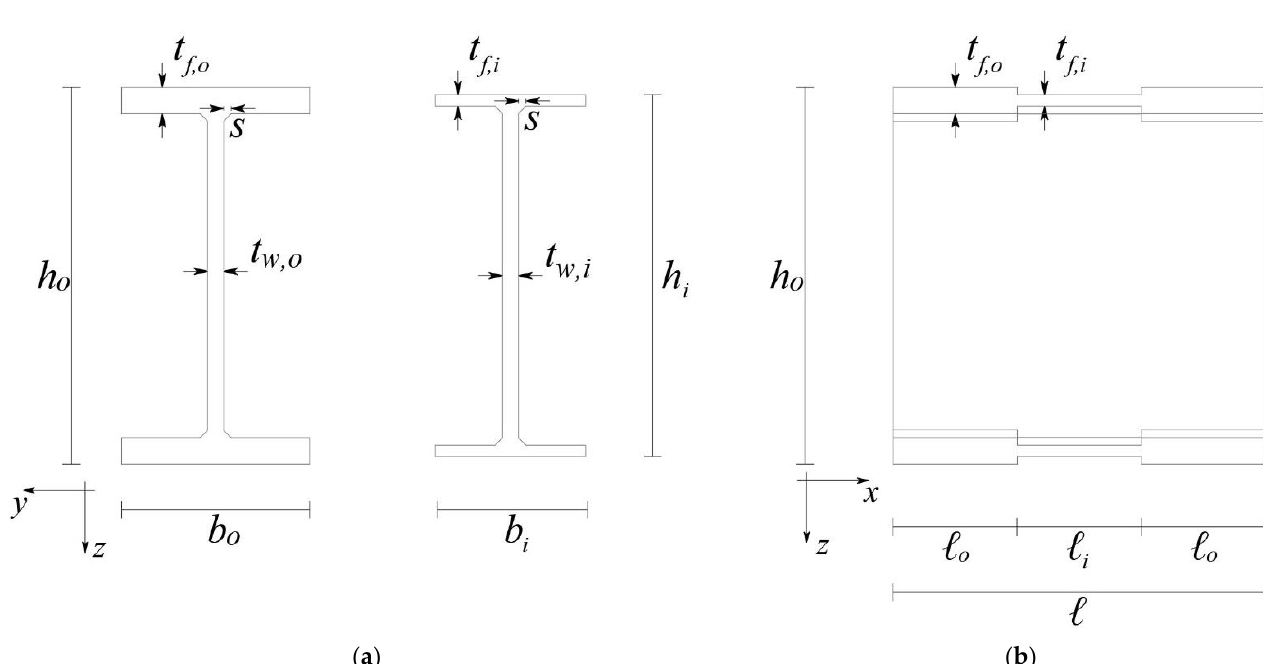
Figure 3. Device geometry: ( a ) cross sections of the inner and outer portions; ( b ) lateral view.